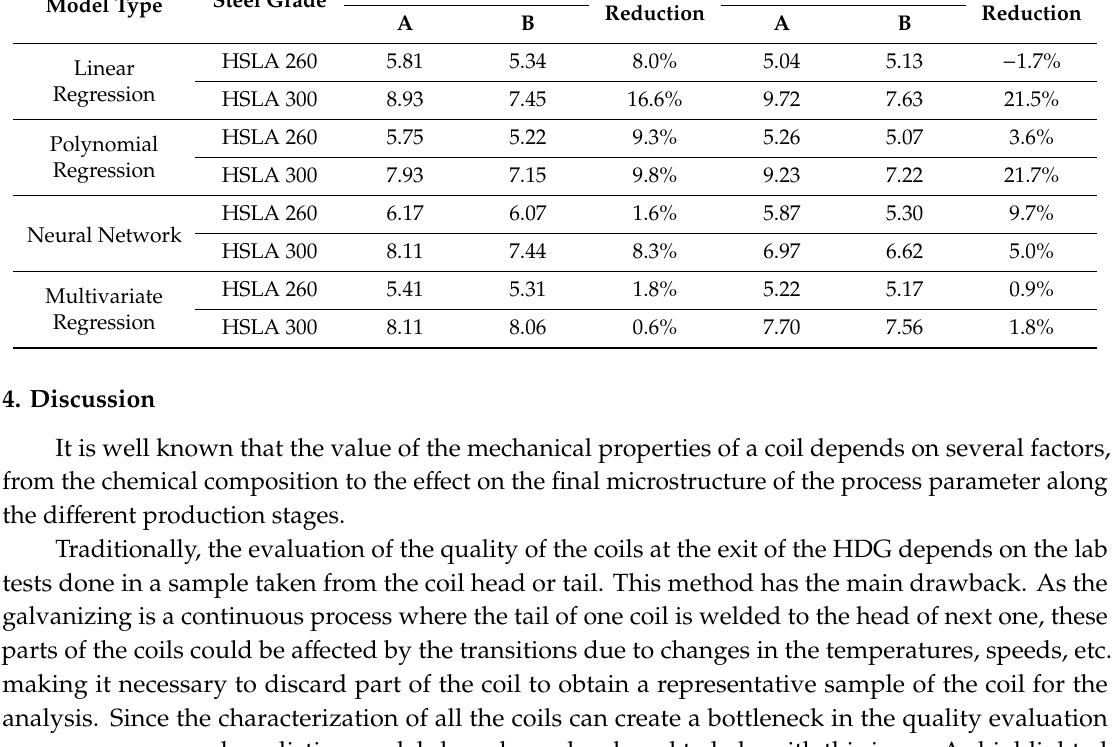
Table 7. Results of the different models and datasets for the prediction of yield strength YS. The minimum error values for each model and steel grade are marked in bold.